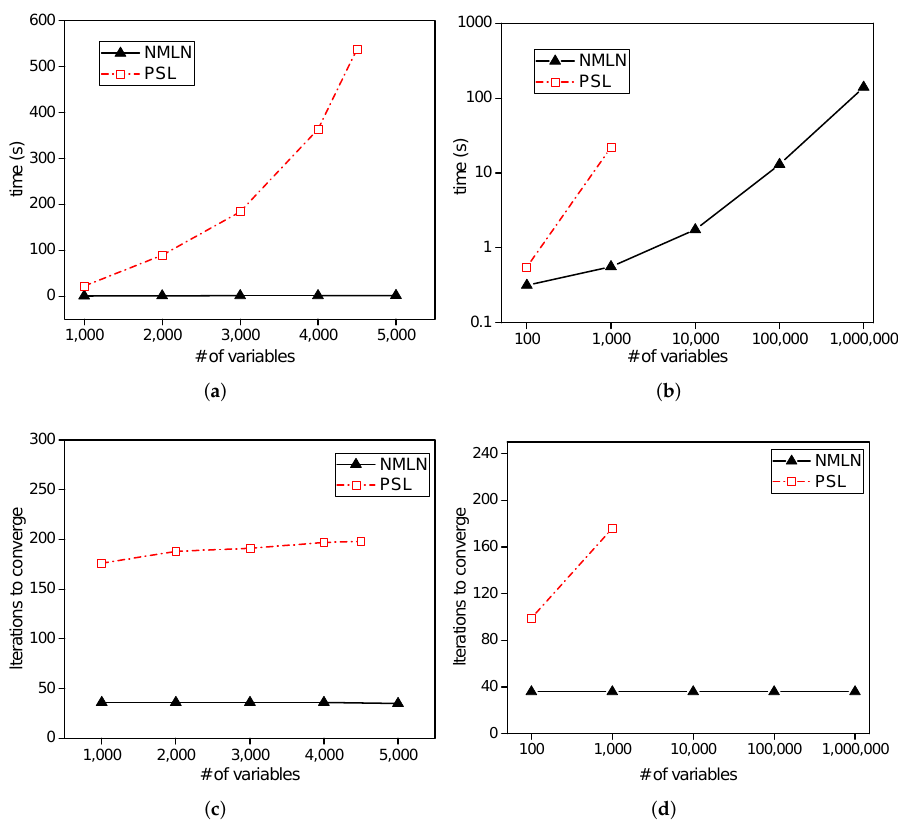
Figure 5. Scalability evaluation on NMLN vs. PSL: ( a ) runtime; ( b ) runtime log scale; ( c ) iterations to converge; ( d ) iteration log